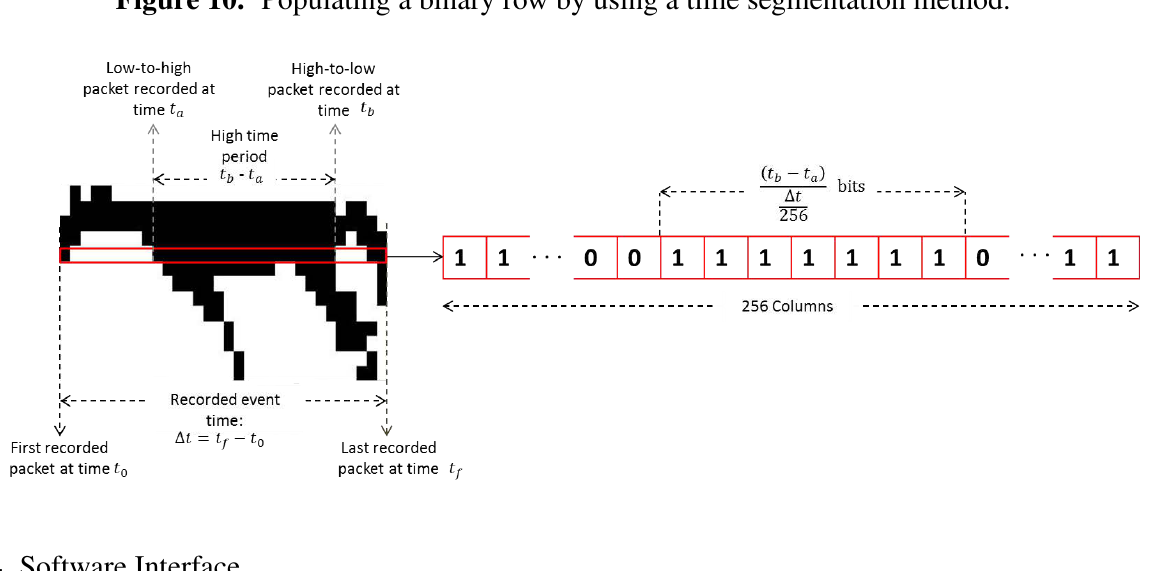
Figure 10. Populating a binary row by using a time segmentation